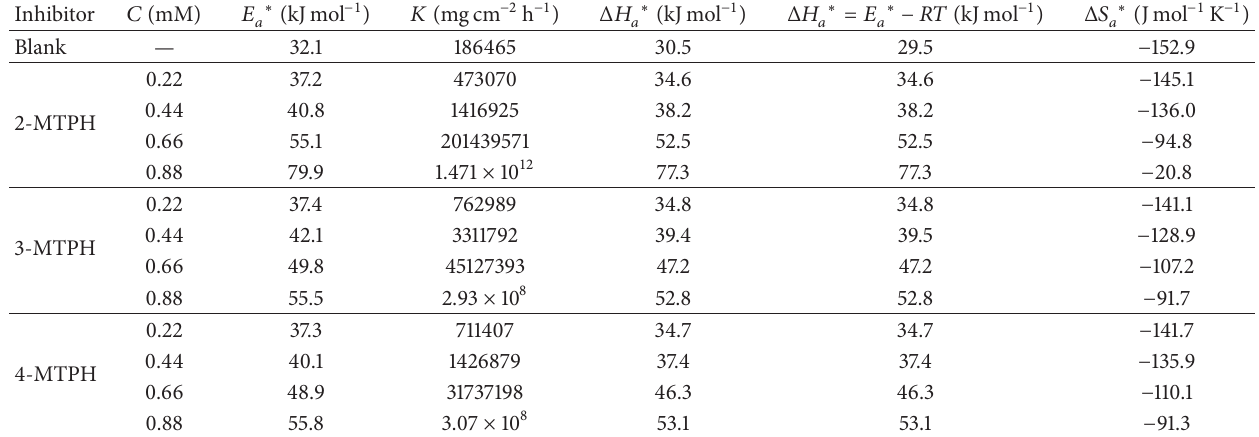
Table 3: Kinetic and activation parameters in the absence and presence of inhibitors in 0.5 M HCl.